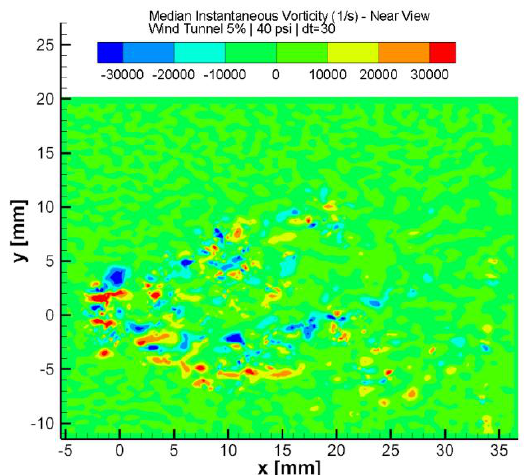
Figure 11. Instantaneous near region vorticity map for 40 psi, 5% wind tunnel speed setting.